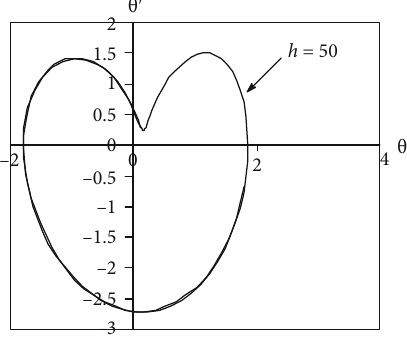
Figure 6: The analytical and numerical stabilities θ ′ against θ at h = 50 .